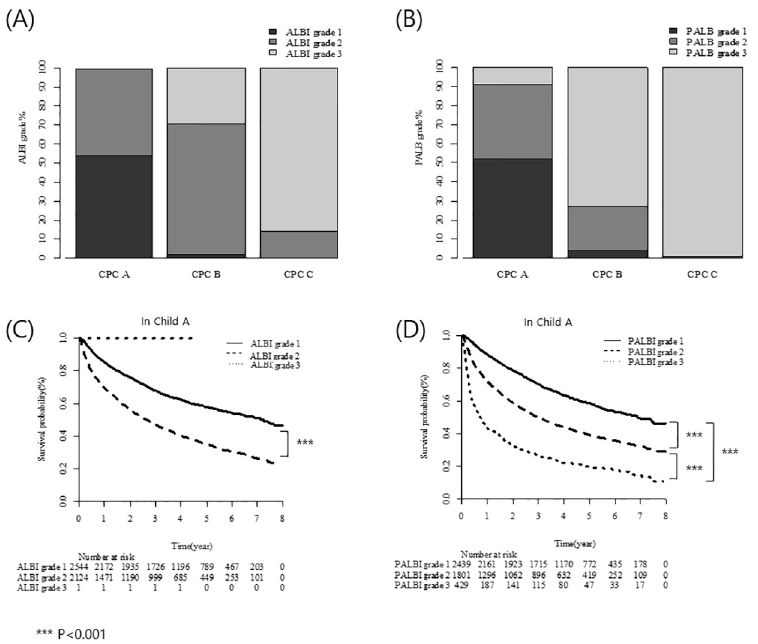
Fig 3. CTP class stratified by ALBI and PALBI grades.